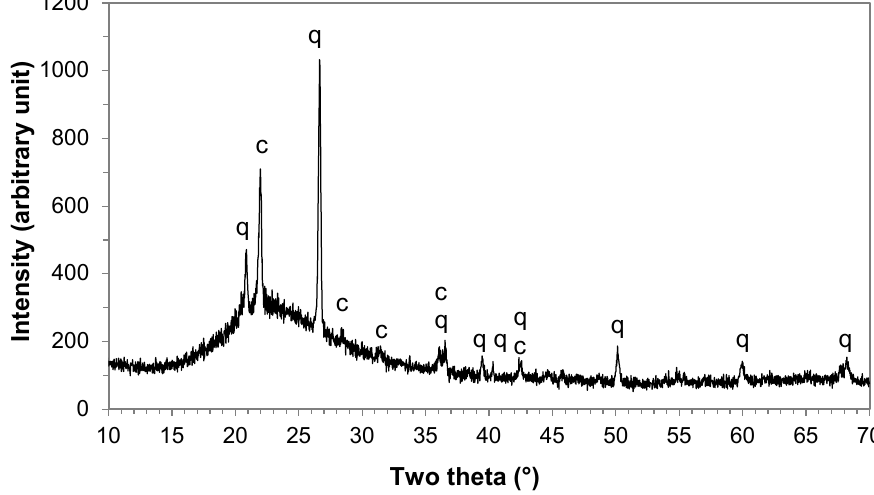
Figure A1. XRD pattern of MK (q: quartz PDF 33-1161 and c: cristobalite PDF 39-1425).